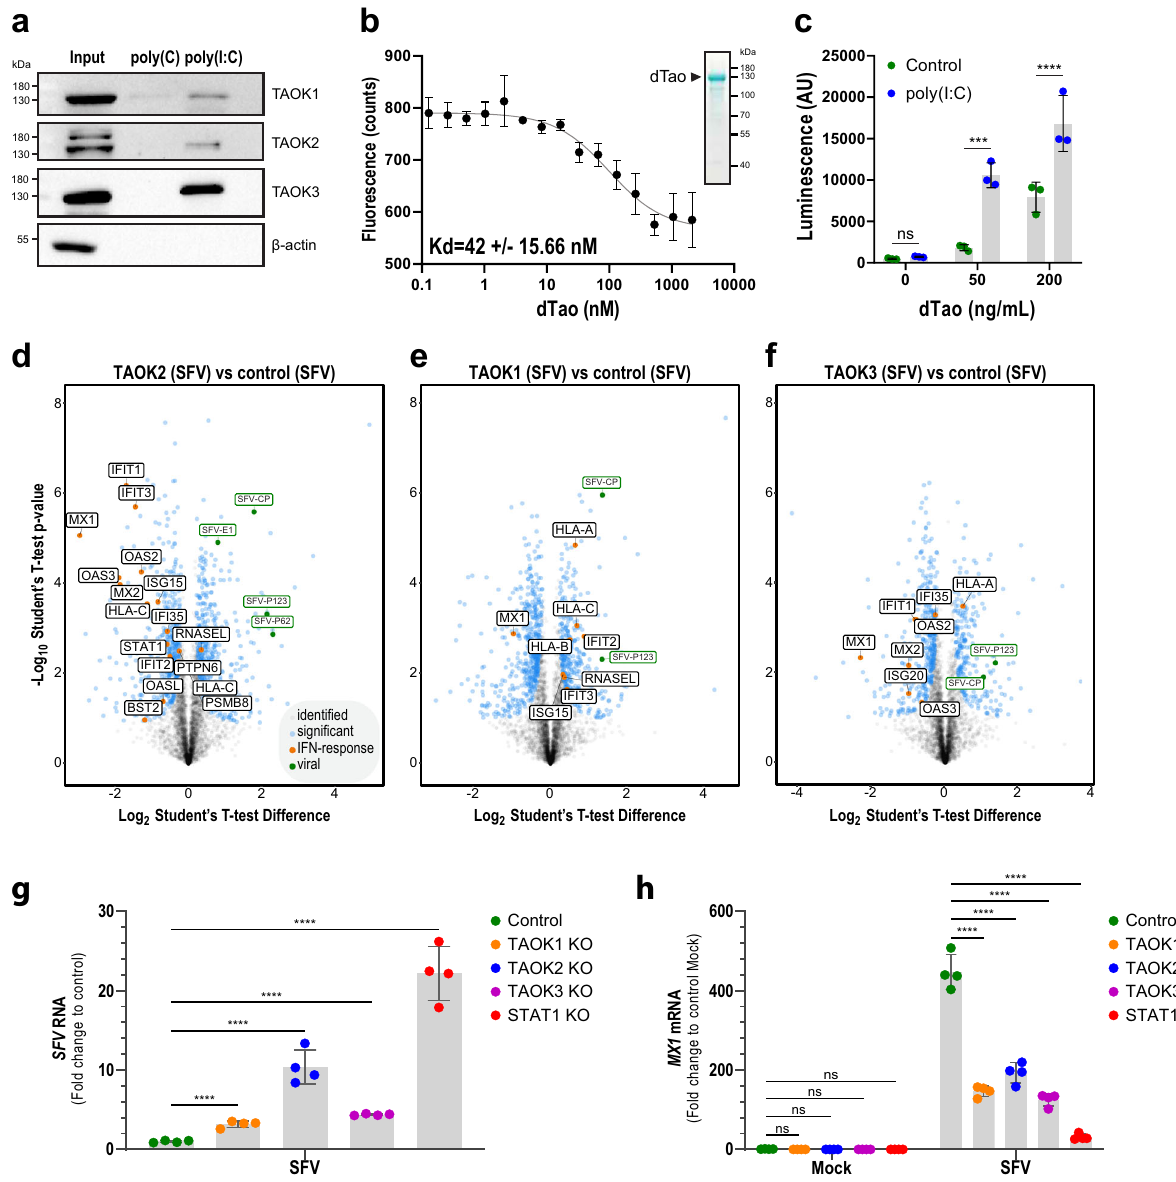
Fig. 5 Drosophila Tao activity is regulated by poly(I:C) binding and human TAOK2 affects ISG expression. a THP-1 cell lysate was incubated with poly(I:C) or poly(C) agarose beads and input proteins or co-precipitating proteins were analyzed by western blotting against the indicated proteins. b Fluorescence quenching assay showing fl uorescence elicited from FITC-tagged poly(I:C) in presence of increasing concentrations of dTao. Shown are the mean fl uorescence intensity ±SD of three measurements. The indicated K d was determined using Af fi nity Analysis v2.2.4 (NanoTemper Technologies). c Increasing amounts of dTao (50 and 200ng/ml) were incubated or not with 0.3mg/ml poly(I:C) and kinase activity was measured by a luminescence-based ATP consumption assay. Bars show the mean of three independent measurements ±SD. **** p <0.0001, *** p <0.001, ns p >0.05 (Two-way ANOVA with Š ídák ’ s multiple comparison test). AU arbitrary units. Data presented in ( a , b , c ) is representative of at least three independent experiments. ( d , e , f ) THP-1 KO or nontargeted control cells were seeded and infected with SFV (MOI 10) for 24h and analyzed for proteome expression. Volcano plots show protein expression patterns of SFV-infected TAOK1 ( e ), TAOK2 ( d ), and TAOK3 ( f ) KO cells as compared to controls. Proteins with signi fi cantly different expression patterns are highlighted in blue, proteins belonging to the GO Term “ cellular response to type-I interferon ” are marked in orange and viral proteins in green. Data presented in ( d , e , f ) is averaged across four biological repeats; a two-sided Student ’ s t -test (S0 = 0.1, permutation-based FDR <0.05) was used to assess the signi fi cance. g , h THP-1 KO and nontargeted control cells (green: control, orange: TAOK1 KO, blue: TAOK2 KO, purple: TAOK3 KO, red: STAT1 KO) were seeded and infected with SFV (MOI 1) or left uninfected (Mock) for 24h and analyzed for SFV RNA and MX1 mRNA transcript levels by RT-qPCR. Shown are the transcript levels normalized to the expression of the housekeeping gene GAPDH for four independent repeats expressed as fold change compared to the averaged biological repeats of the control. Error bars show the mean±SD. **** p <0.0001 (One-way ANOVA ( g ) or two-way ANOVA ( h ) both with Š ídák ’ s multiple comparison test). ns not signi fi cant. Data presented in ( g , h ) is representative of three independent experiments. Source data are provided as a Source Data fi